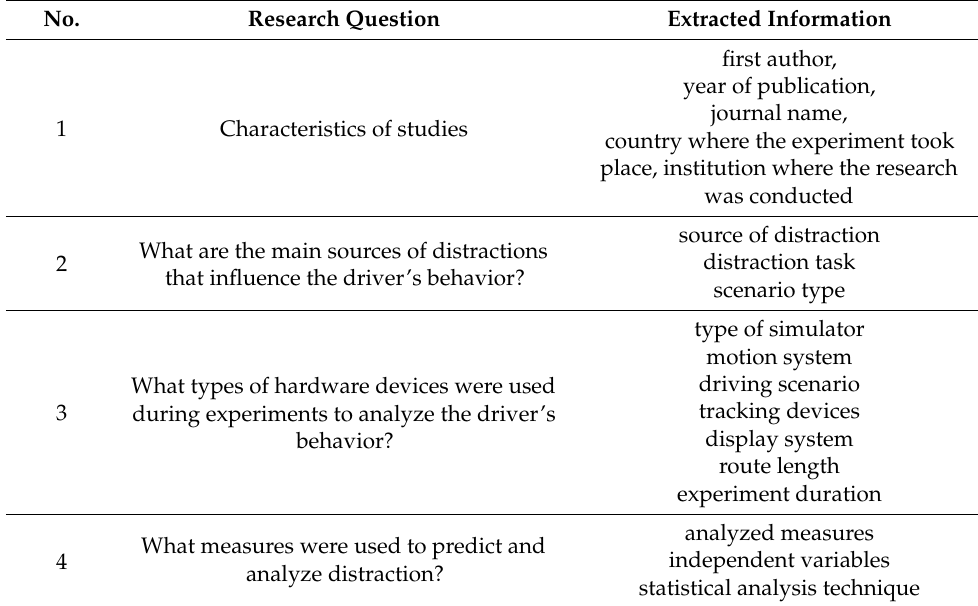
Table 1. Extracted information grouped by